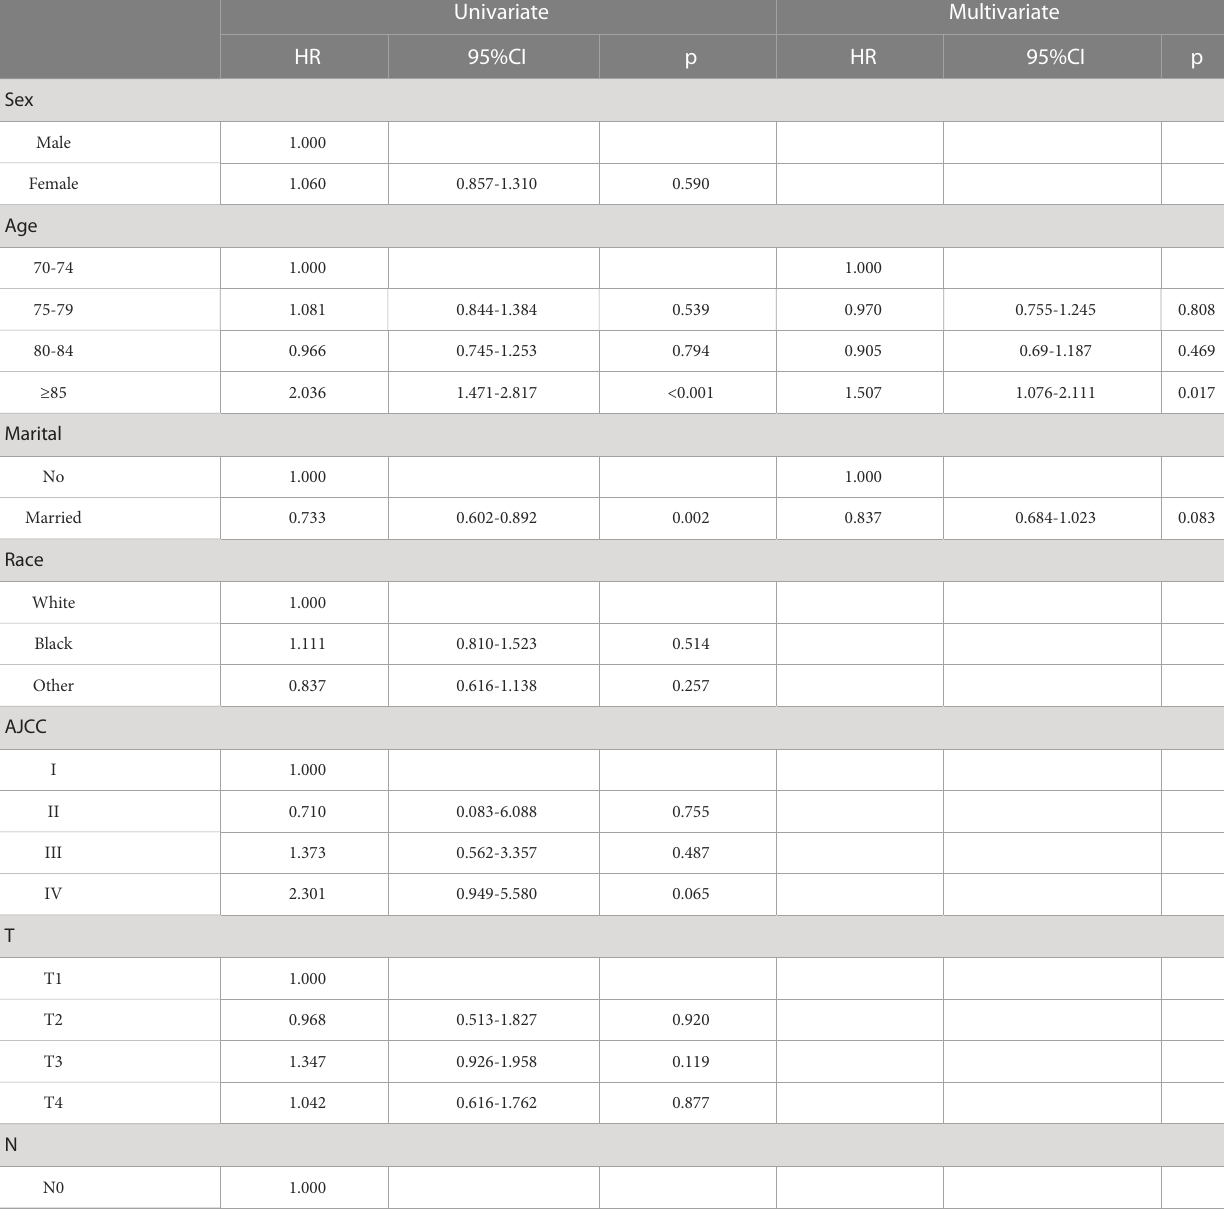
TABLE 4 Univariate and multivariate Cox regression analysis of CSS after propensity score matching. Univariate